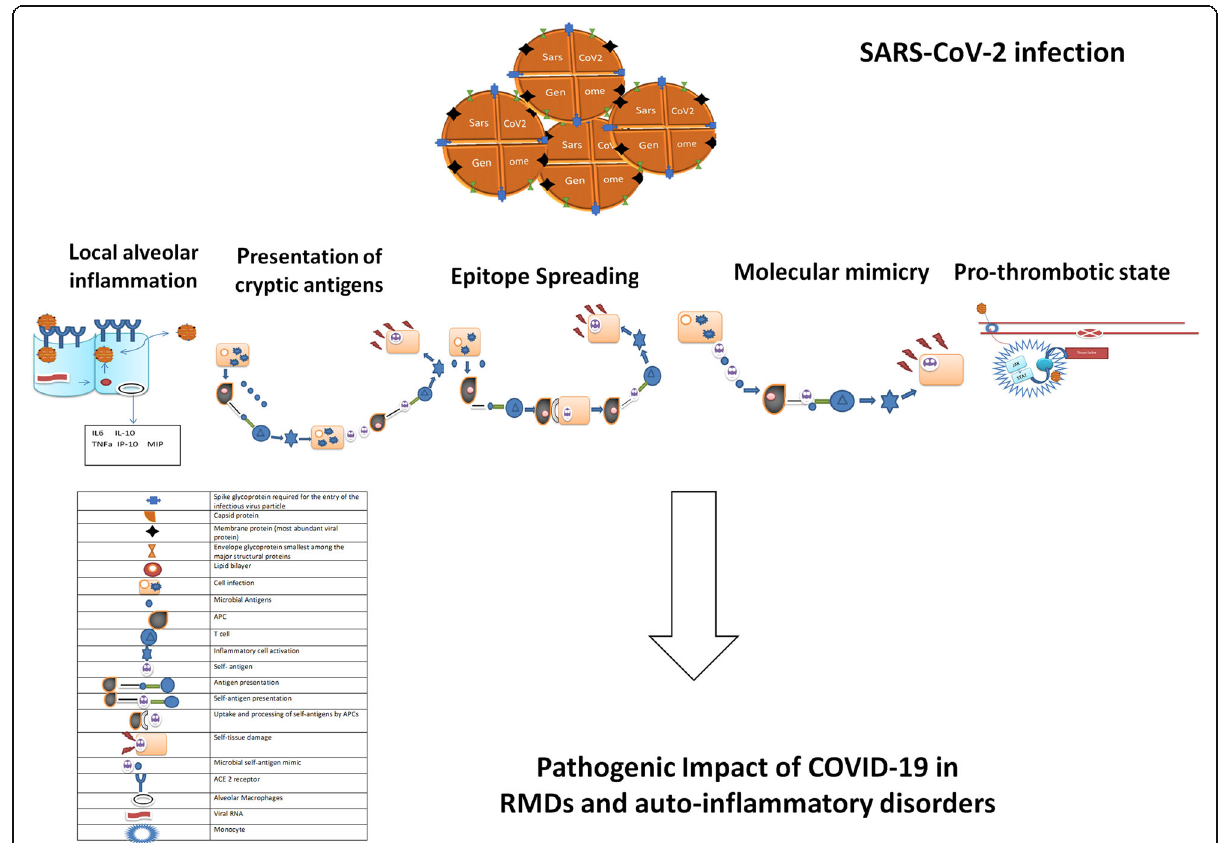
Fig. 1 The figure describes the structure of SARS-CoV2 and the possible infection associated mechanism of autoimmunity. SarsCov2 infects epitelial cells by receptors angiotensin converting enzyme 2 (ACE2) resulting in replication and release of the virus with consequent pyroptosis and the release of damage associated molecular patterns. This process leads to local inflammation and secretion by alveolar macrophages of pro- inflammatory cytokines such as IL-6, IL-10, macrophages inflammatory protein 1 alfa (MIPa), and TNF. Furthermore, this figure describes epitope spreading where persistent infection leads to the uptake of microbial antigens by antigen presenting cells (APCs) and antigen presentation of T- cells. This mechanism carries an inflammatory cascade resulting in a tissue damage, a possible uptake of self-antigens by APC and subsequent presentation of these self-antigens to Tc ells causing an anti-self-reaction. After microbial infection self-antigens could be recognised and processed by APC; subsequently cryptic epitopes could be exposed and presented to self-reactive T-cells leading to an autoimmune response. This figure also describes the mechanism of molecular mimicry where microbial antigens could share antigenic similarly with self-antigens. The presentation of these self-antigen mimics by APC to cross reactive cells leads to an inflammatory response because T cells recognize both the microbial mimic and its respective self-antigens. Finally, viral particles and proinflammatory cytokines induce the activation of blood monocytes which respond by inducing tissue factor membrane expression contributing to a pro-thrombotic